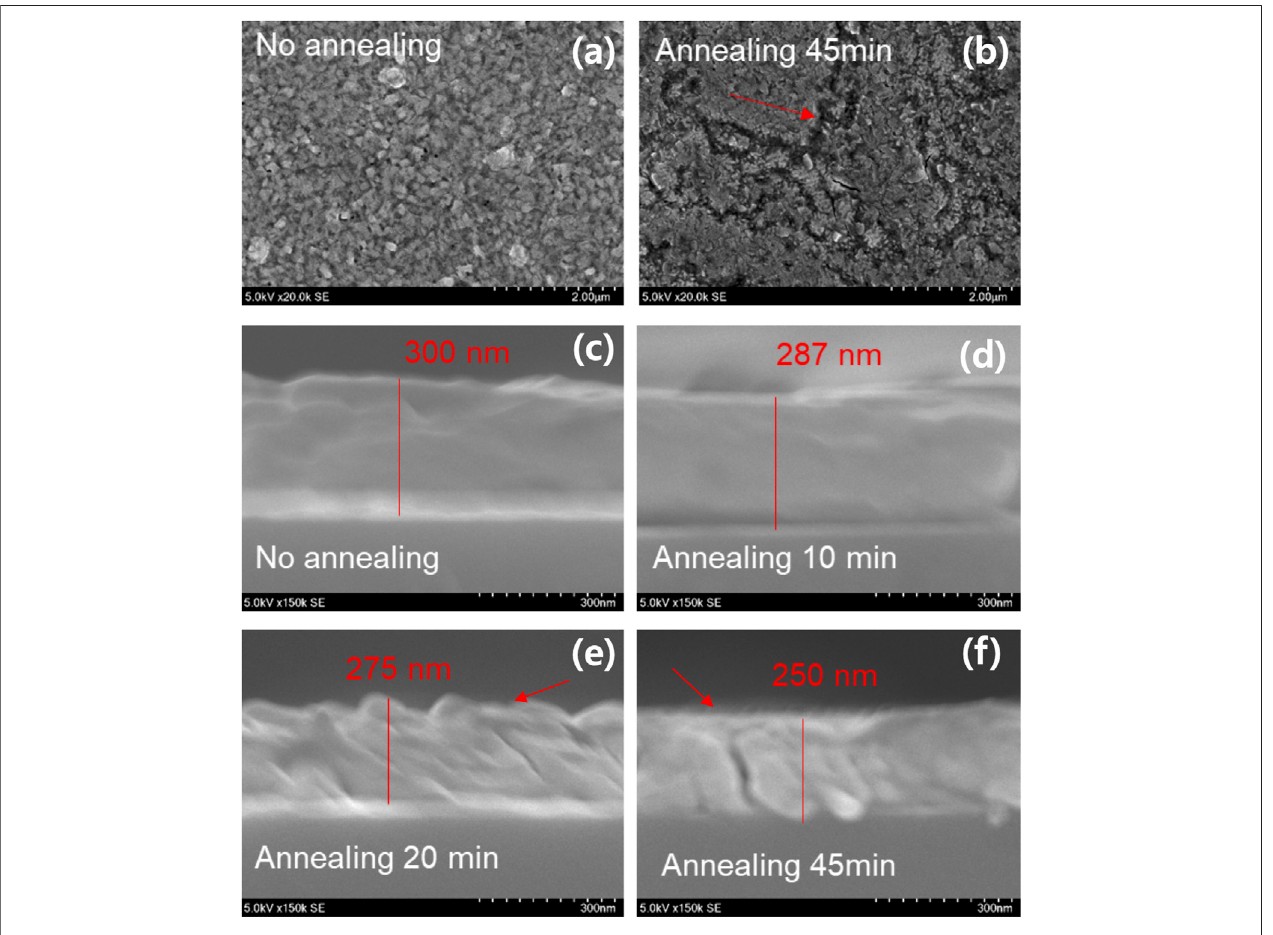
FIGURE 3 | Surface morphologies after the deposition of MAI of (A) no-annealing and (B) 45-min annealing samples. The surface is dramatically changed with the appearance of a valley. (C – F) Additionally, the thickness decreases from 300 to 250 nm with increase in the annealed time. The deep void can be observed in both the 20- and 45-min annealing